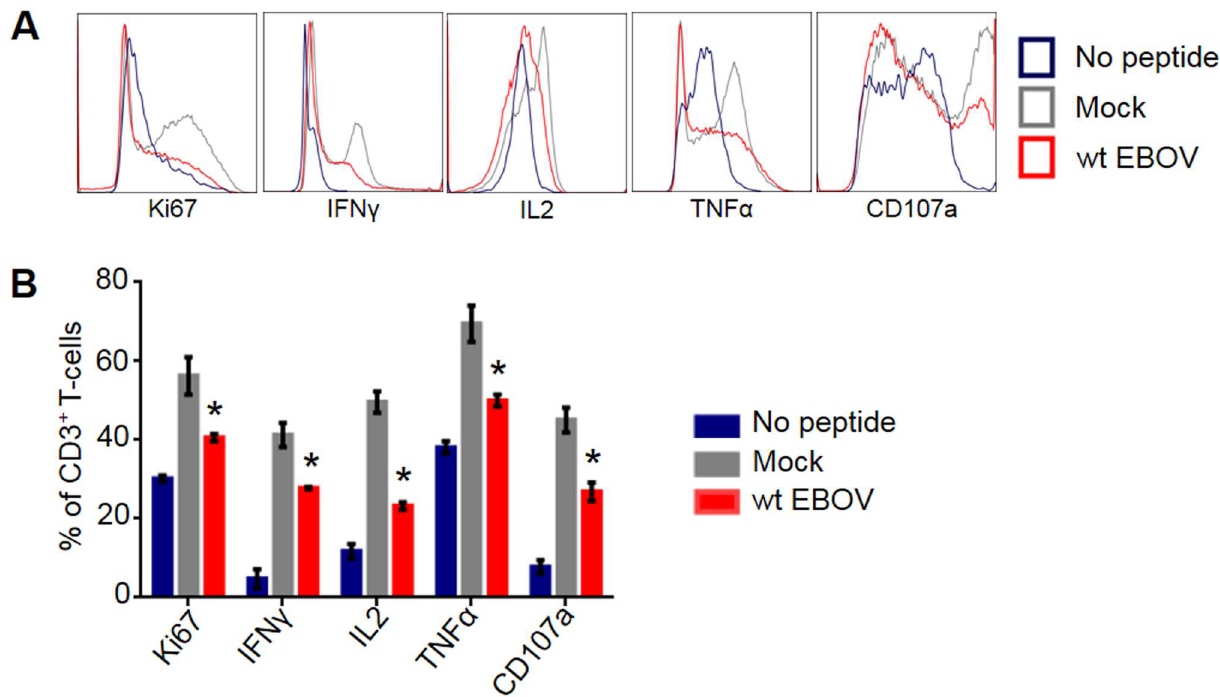
Fig 1. EBOV suppressesactivation of T cells. CMV-specificT-cell responderswere isolatedand expandedfrom CMV + -donors as describedin the Materials and Methodssection. In parallel,monocyteswere isolatedand differentiatedinto DCs from autologous donors. DCs were simultaneously pulsed with CMV-peptides and infected with wt EBOV. Followingovernight stimulation,expanded CMV-responders were added at a 1:1 ratio with control (no peptide)or CMV-pulsedDCs. A. Representative flow cytometry histograms showingthe levels of the proliferation marker Ki67, cytokines associatedwith T-cell activation, and the marker of degranulation CD107a. B. Percentageof markers associatedwith activationin one representative donor. Mean values with SE based on triplicate wells from a single donor. The asterisks indicate statistically significantdifferences of wt EBOV-infected samples (p < 0.05)comparedto mock. Testing of T cells from another donor resulted in essentiallysimilar